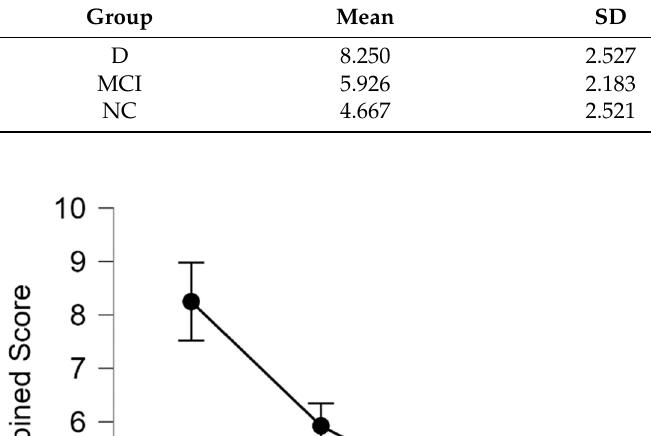
Table 8. Combined score descriptive statistics in NC, MCI, and D groups.